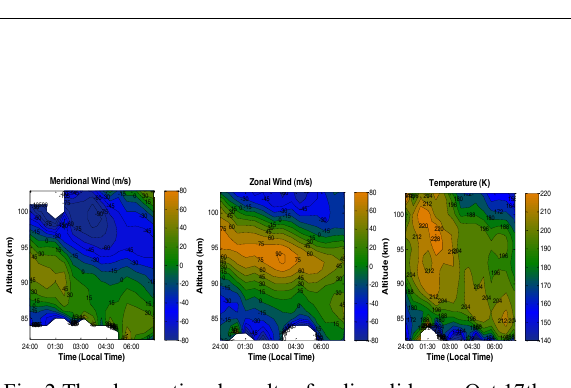
Fig. 2 The observational results of sodium lidar on Oct 17th 2017. (a) meridional wind. (b) zonal wind. (c)